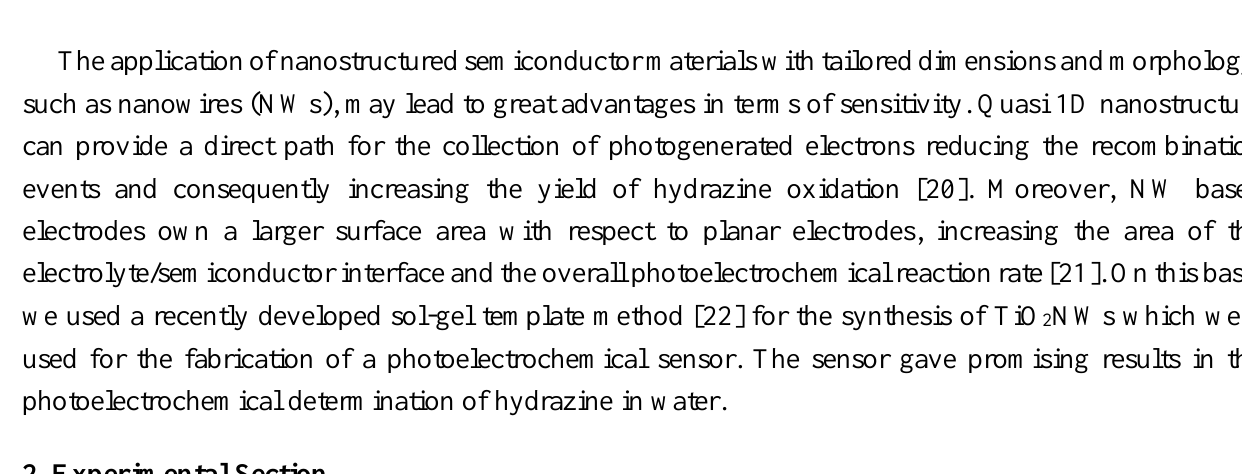
Figure 1. Sensing scheme of hydrazine at a TiO 2 nanowire array (TiO 2 NWA)photoanode; CB and VB are the semiconductor conduction and valence